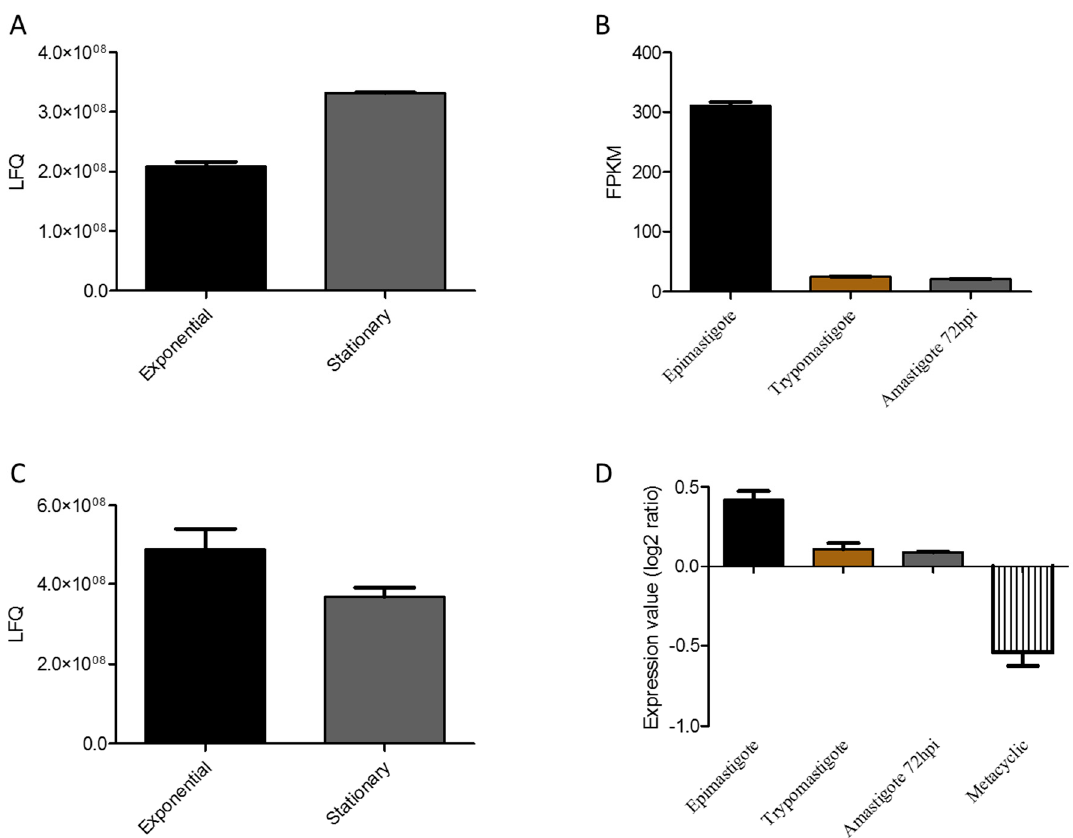
Figure 7. Protein and mRNA regulation of amastin and ADP/ATP mitochondrial carrier. ( A , C ) show the LFQ values for the amastin and ADP/ATP mitochondrial carrier protein in the T. cruzi exponential and stationary growth phases, respectively. These values were obtained by quantitative proteomics analysis in this study. ( B , D ) show the mRNA expression of amastin and ADP/ATP mitochondrial carrier in the epimastigote, trypomastigote, amastigote 72 h post infection (hpi), and metacyclic trypomastigote. These values were obtained from the TrytripDB database according to Mining et al. [28] and Li et al. [29].